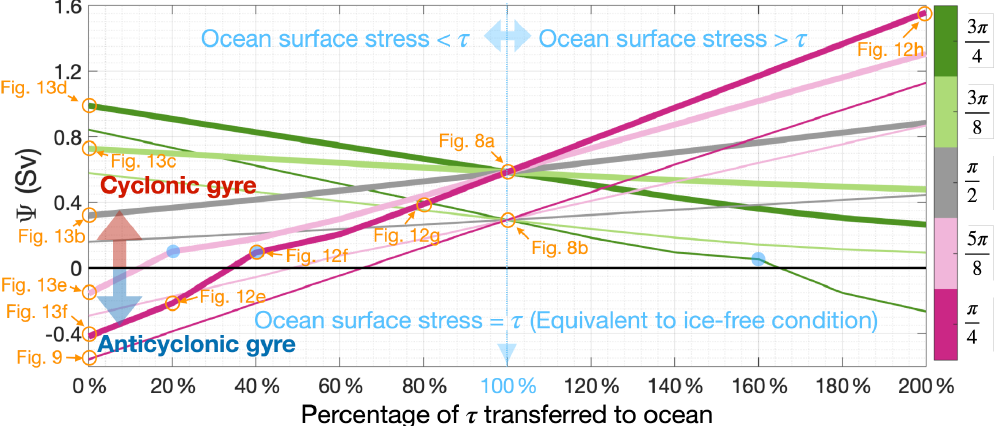
Figure 10. Simulated maximum gyre streamfunction ( (cid:57) ) for cyclonic wind stress curl experiments. Positive streamfunction values are cyclonic and negative values are anticyclonic. The line colours indicate the angle between the wind direction and the sea ice edge, as shown in Fig. 7. Thick lines denote the simulations with strong wind stress curl (i.e. StrongCyclonic; Fig. 6a) while thin lines denote the simulations with weak wind stress curl (i.e. WeakCyclonic; Fig. 6b). Blue dots mark the turning points where the lines of simulated (cid:57) have a discontinuity in gradient caused by the occurrence of dipoles or tripoles. Orange circles with texts mark the simulations shown in Figs. 8, 9, 12,